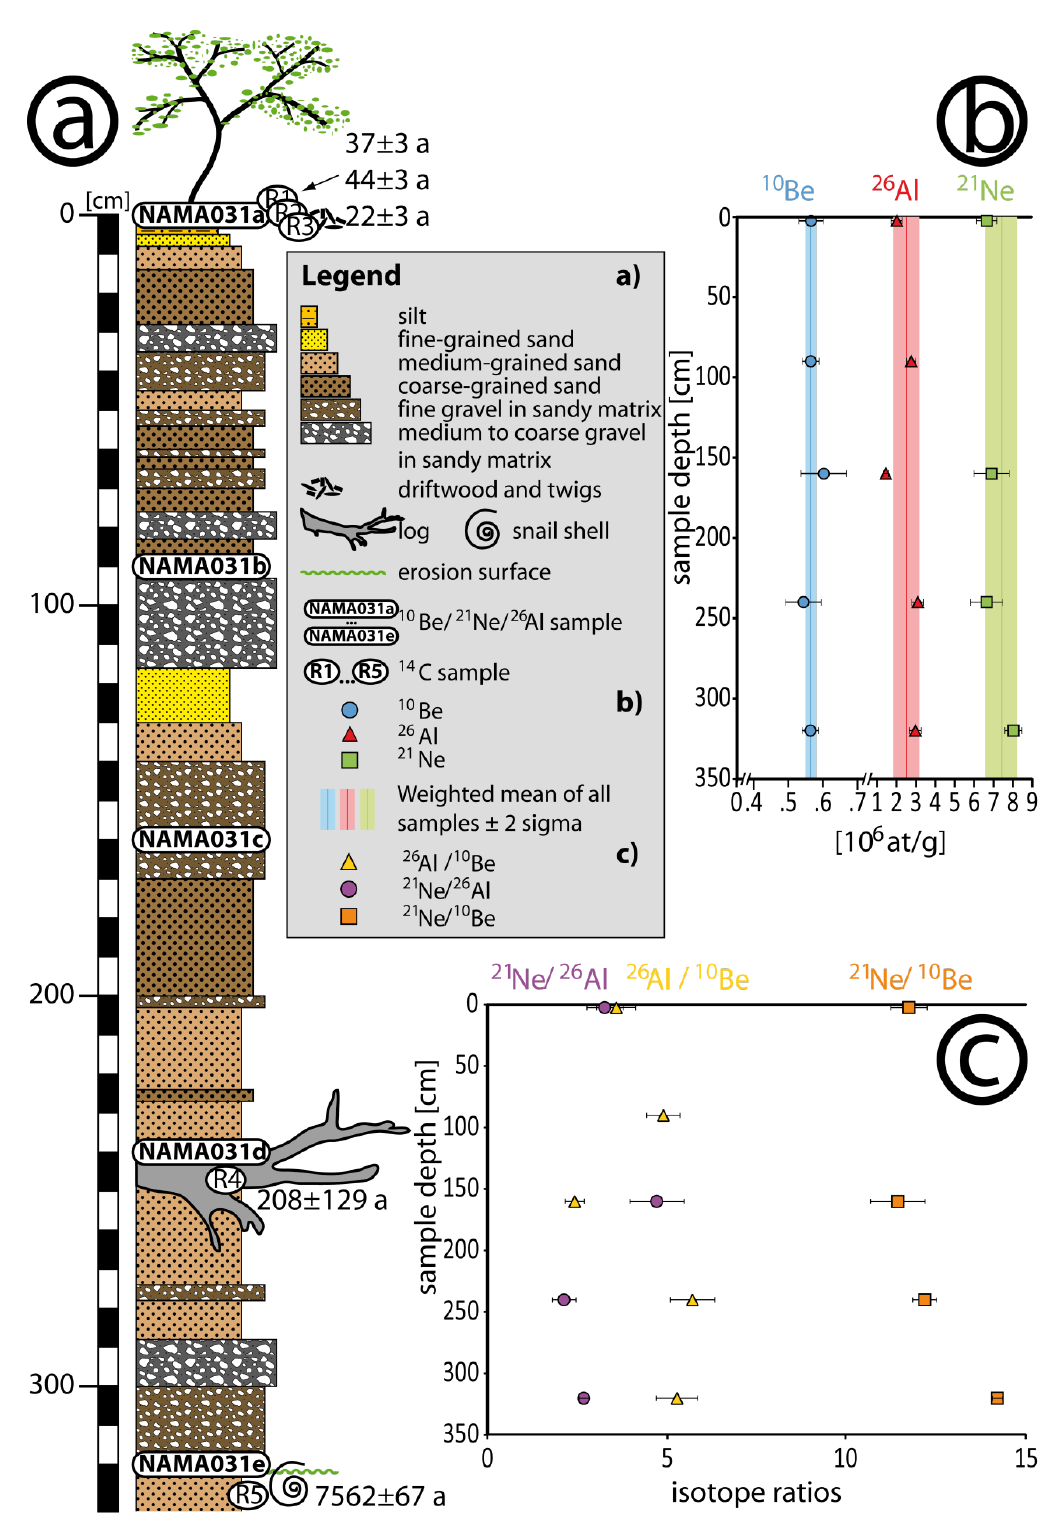
Figure 2. ( a ) Stratigraphic column of profile NAMA031 and carbon-14 ages (for R1 – R5). ( b ) Depth-related CN concentrations (for NAMA031a to NAMA031e), mean and 2 sigma uncertainty of CN along the profile. ( c ) Isotope ratios versus sample depth at the 2 sigma level.